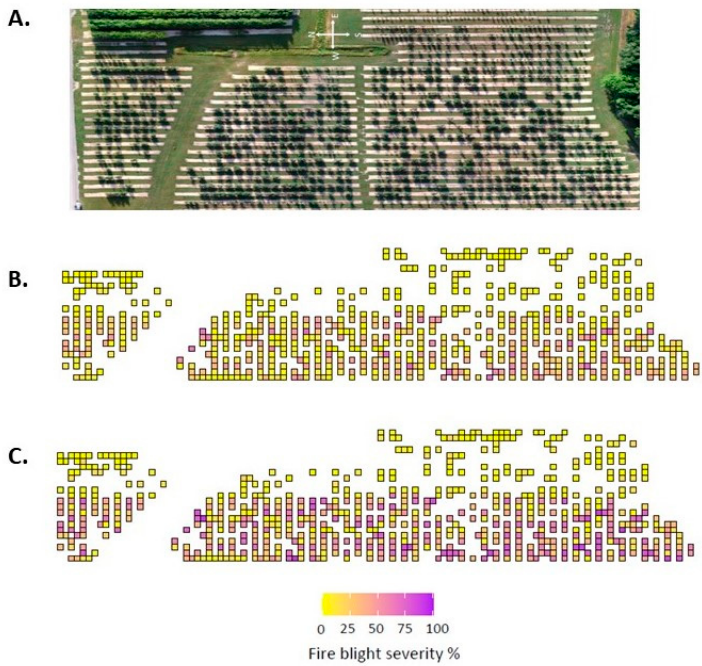
Figure 3. Heat map of fire blight severity for the 667-tree main collection subset. ( A ) Aerial image of the field. ( B ) Initial severity average in late June. ( C ) Severity average 3 weeks later, mid-July. Each square represents a tree. The compass in A. shows the cardinal directions of the field. Fire blight average severity calculated as (number of infected shoots/total number of shoots) × 100 for the west and east facing side of the tree, then averaged together.